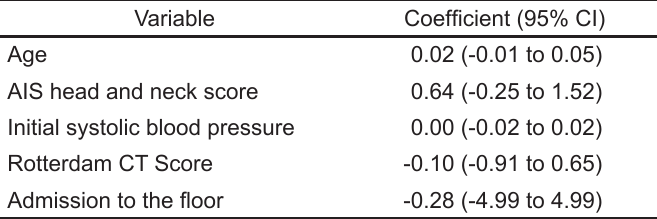
AIS , abbreviated injury severity; CT , computed tomography *Adjusted coefficients for predicting hospital length of